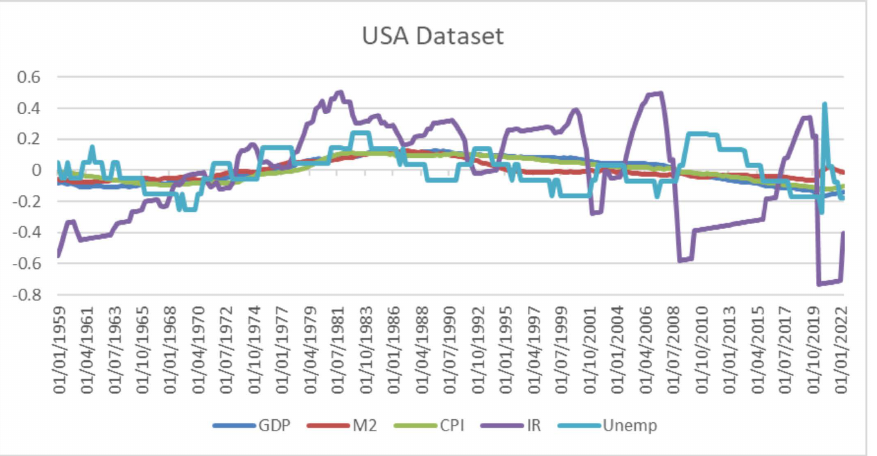
Figure 2. Macroeconomic stationary variables.